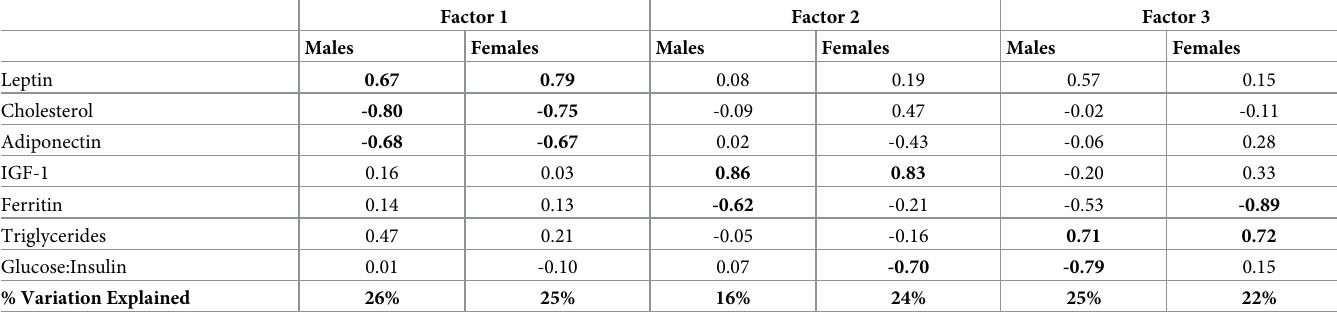
Table 2. Principal component factor loadings (varimax